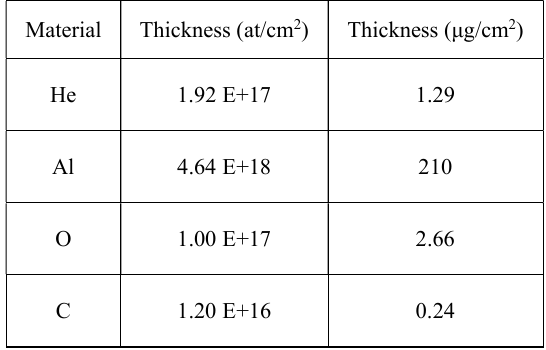
Table 1. The density of scattering centres of helium, aluminum, oxygen, and carbon atoms present in the target. Material Thickness (at/cm 2